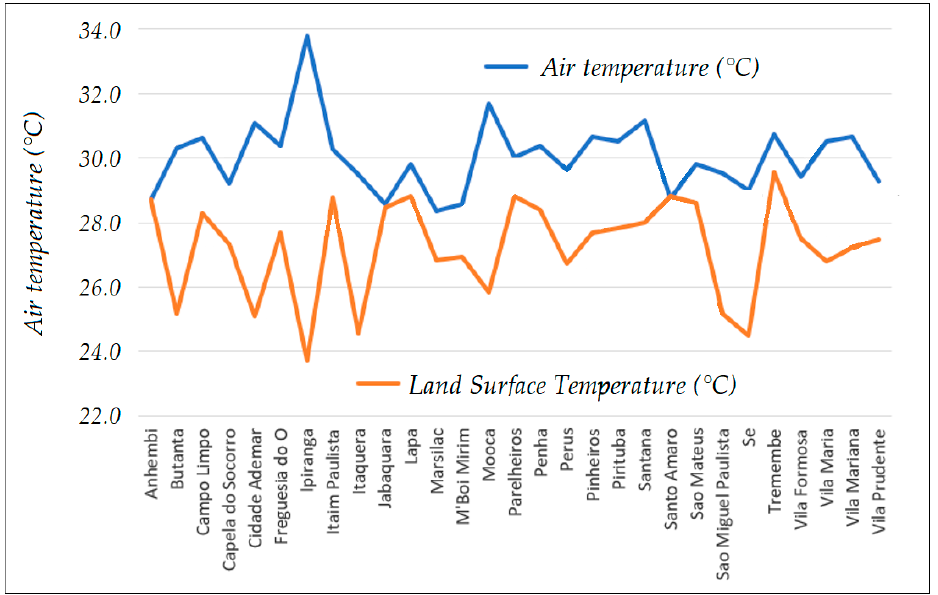
Figure 4. Graph of air temperature and land surface temperature at each CGE’s weather station in São Paulo City on 21 January 2019 in the spring–summer season. Data source: Management Centre of Climate Emergencies of the São Paulo City, 2019.